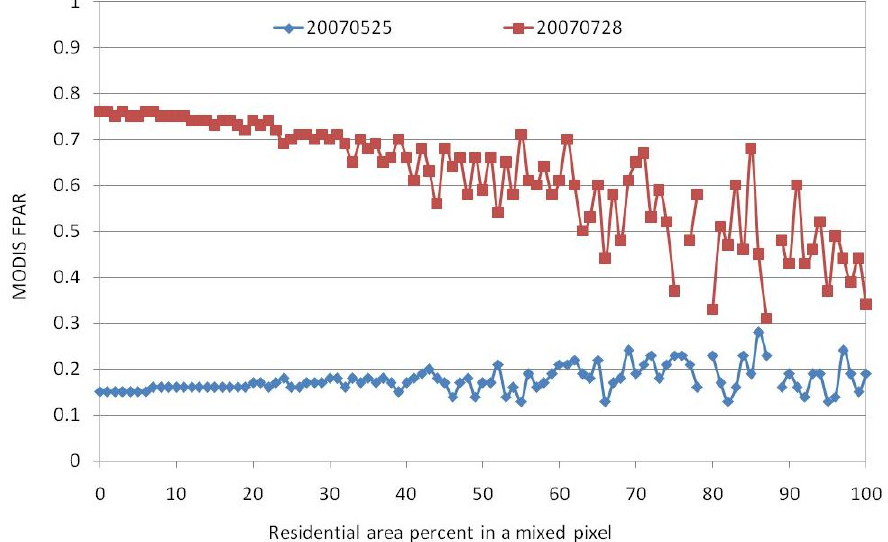
Figure A1. The changing trend of FPAR in the mixed pixels affected by residential area